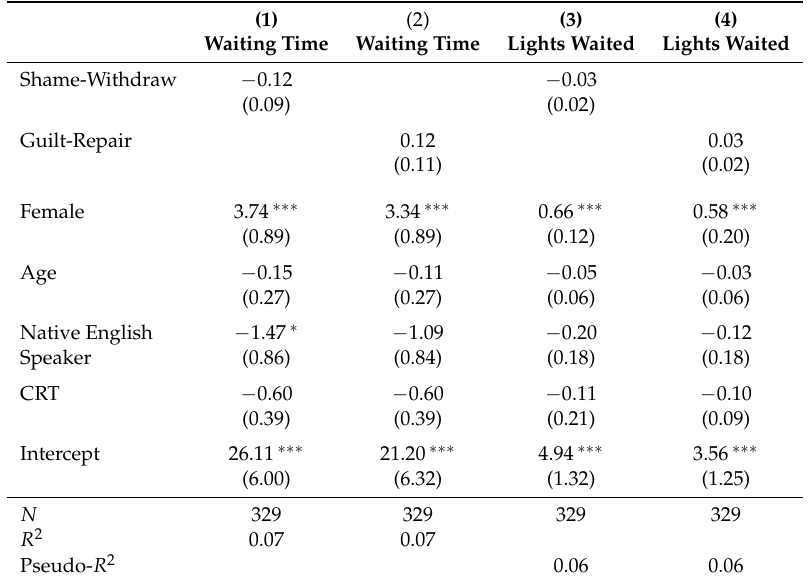
Table A3. Predicting Rule-following by Shame-Withdraw and Guilt-Repair: Regression Results.